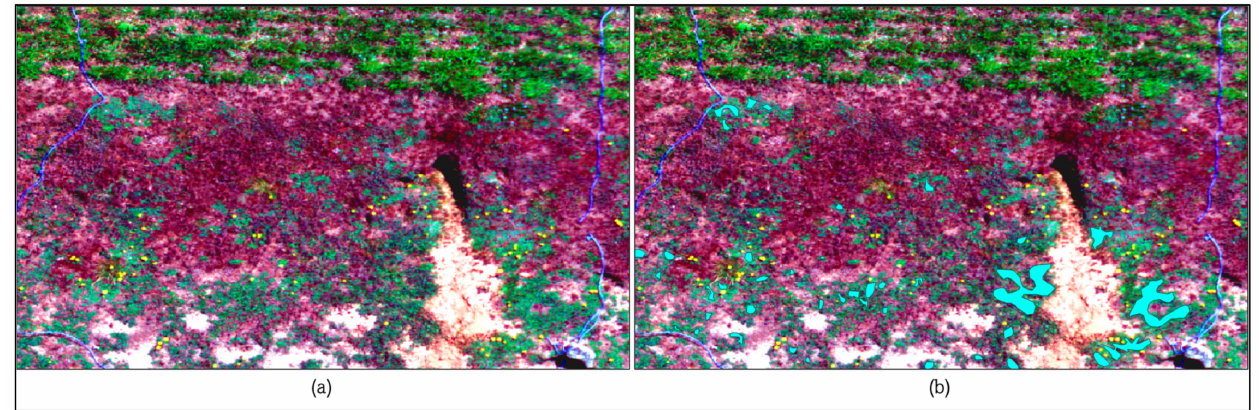
Figure 4. Ground truth labelling for hawkweed foliage detection model: ( a ) Actual multispectral image, ( b ) Polygon labelling over hawkweed foliage (EPSG:4326—WGS